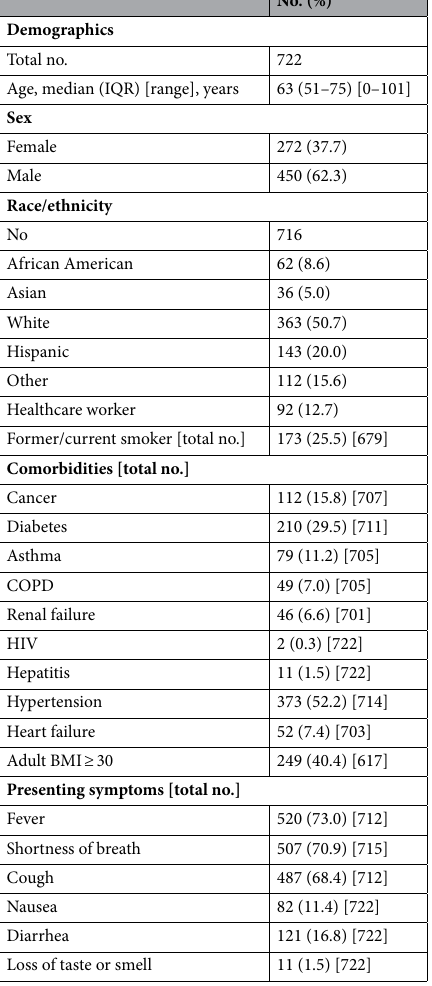
Table 1. Demographics and baseline characteristics of patients admitted to HMH hospitals and laboratory confirmed with COVID-19 by CDI enhanced COVID-19 test. IQR interquartile range, COPD chronic obstructive pulmonary disease, BMI body mass index.